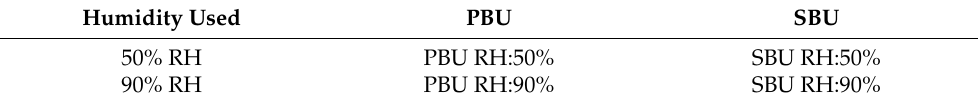
Table 2. Groups used in this